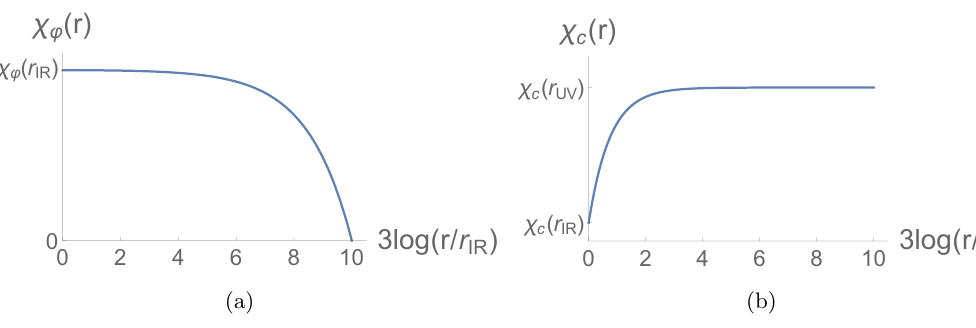
Figure 12 . The lowest lying radial eigenmodes for ’ and c for w IR (cid:24) 10 (cid:0) 2 plotted in the physical radial coordinate t = 3 R log( r=r IR